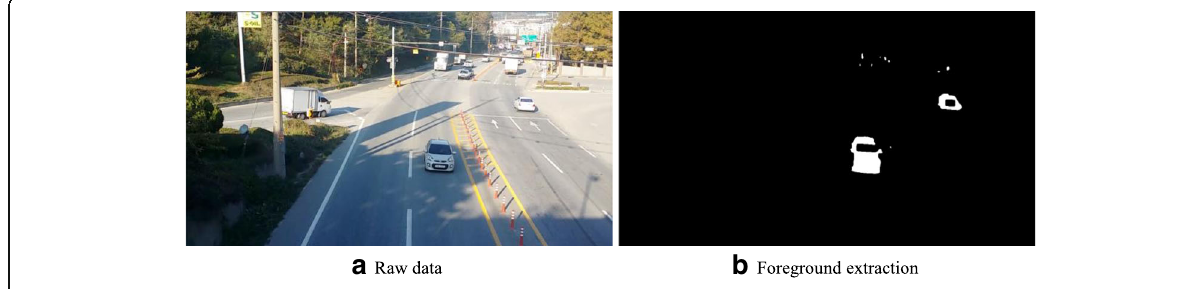
Fig. 2 Raw data and foreground extraction. a Raw data. b Foreground